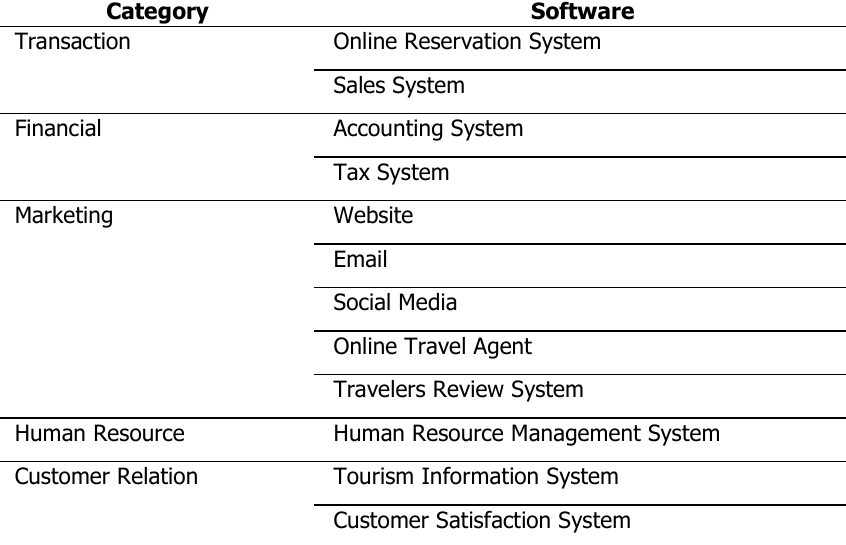
Table 4. Software Requirements Based on Management Information Systems